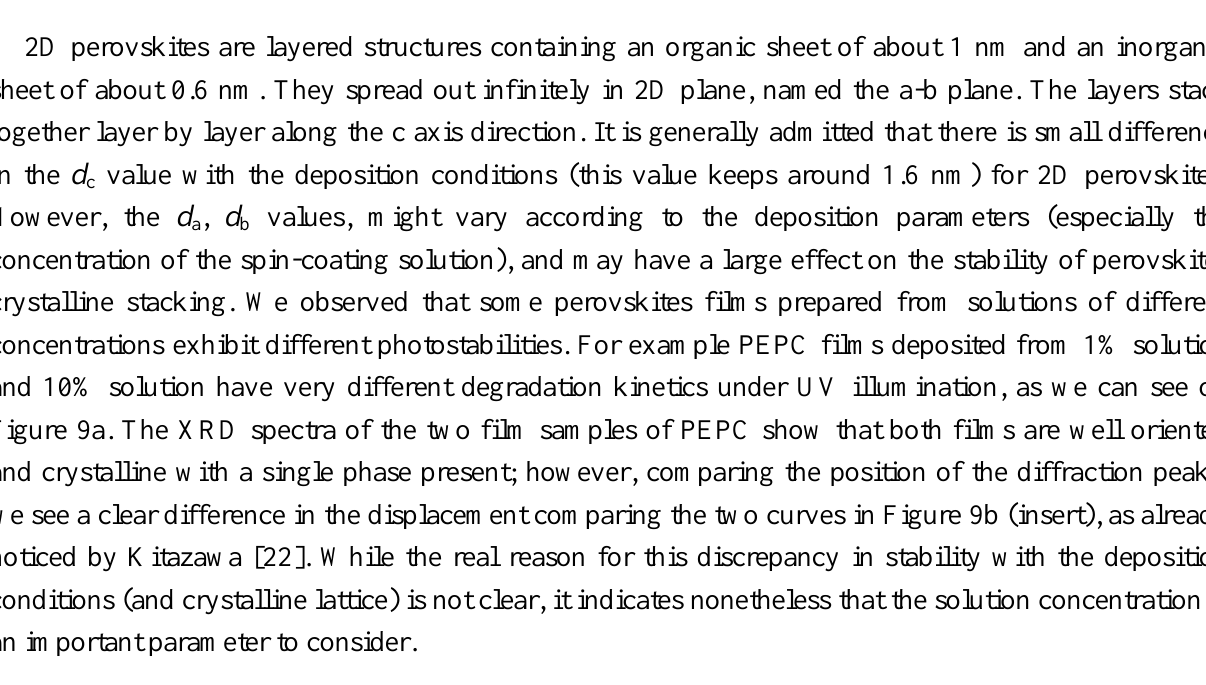
Figure 9. ( a ) Evaluation of PL intensity as a function of illumination time for two PEPC thin films prepared from 1% and 10% in dimethylformamide (DMF) solution. The laser power is 7 mW at 325 nm (corresponding to a fluence 0.175 W·cm −2 ); ( b ) XRD spectra of PEPC thin films prepared from 1% (green line) and 10% (red line) in DMF